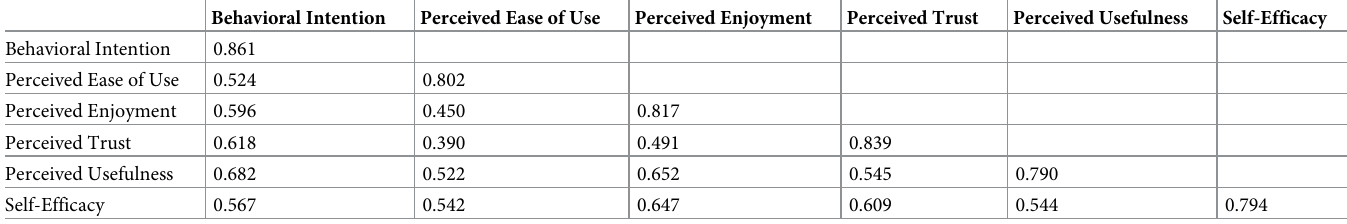
Table 3. Correlation coefficient between various